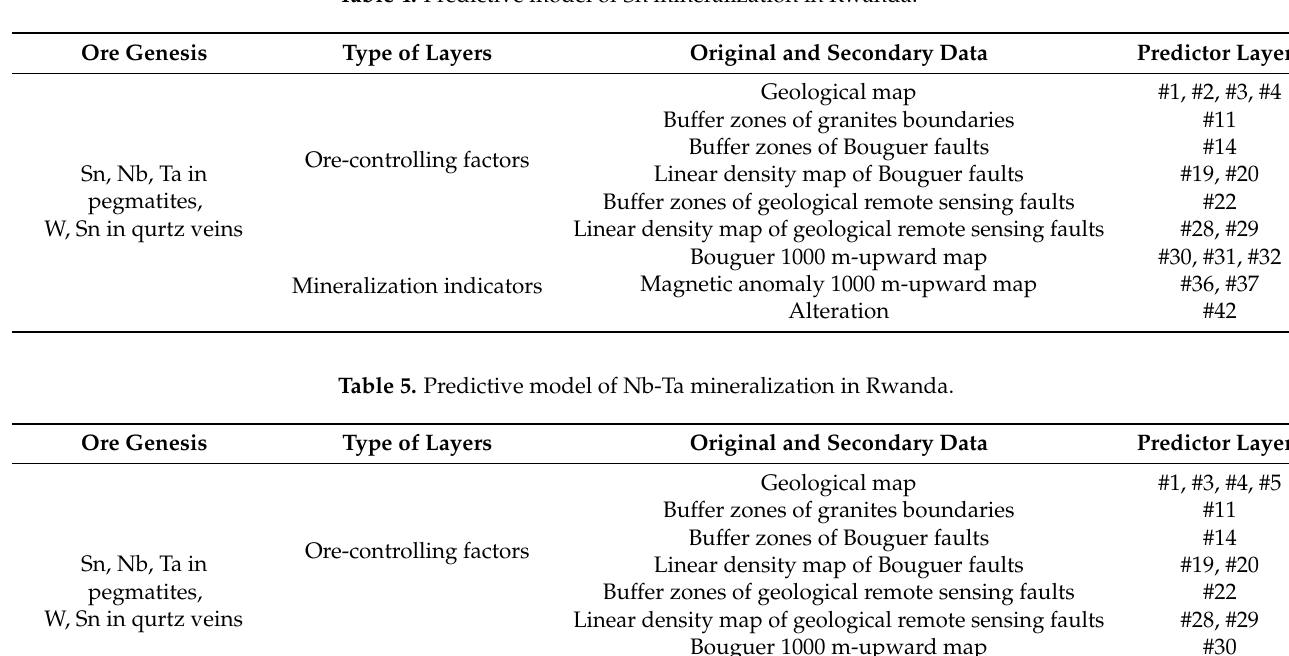
Table 4. Predictive model of Sn mineralization in Rwanda.